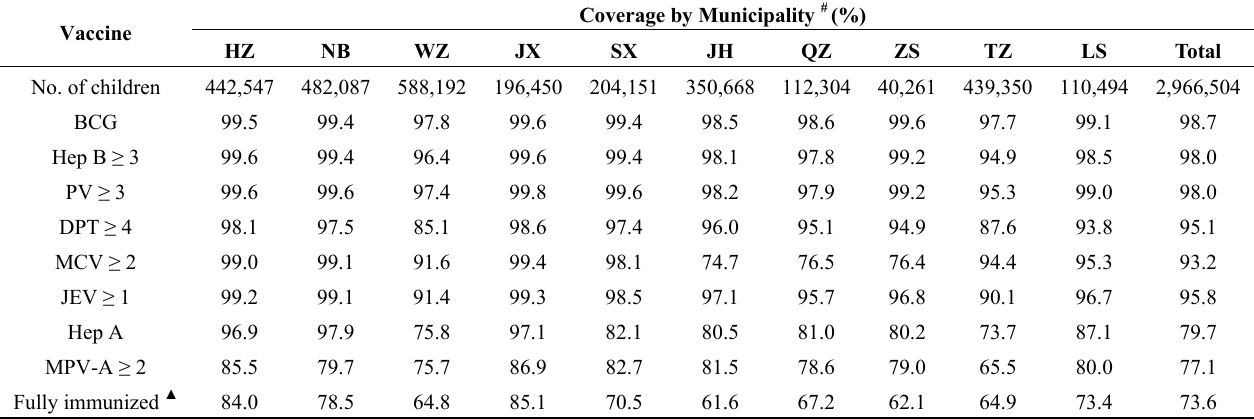
Coverage by Municipality # (%)